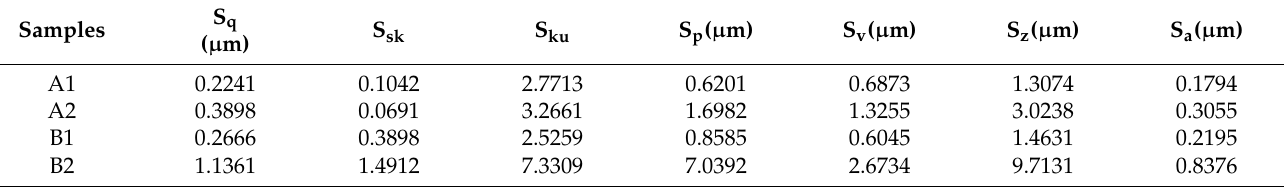
Table 9. Results of areal topography